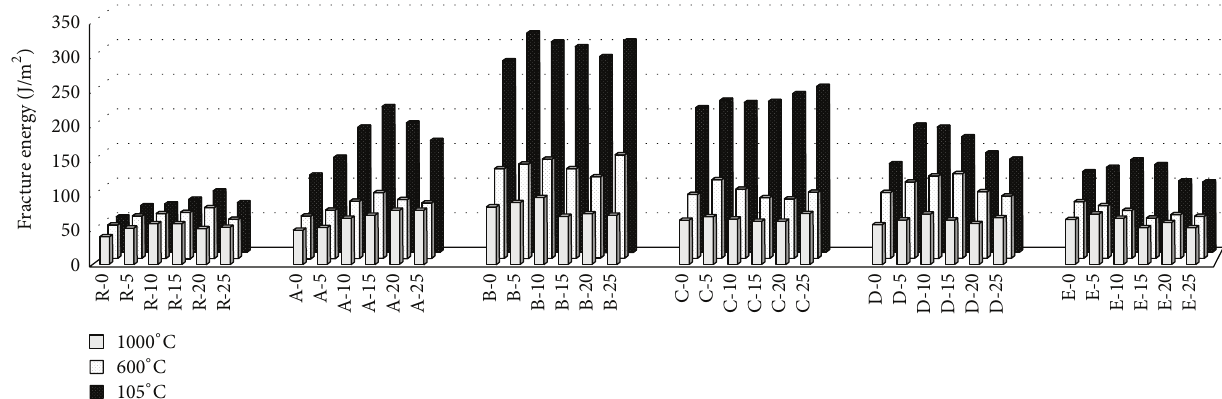
Figure 8: Impact of different composition and temperature loading on fracture